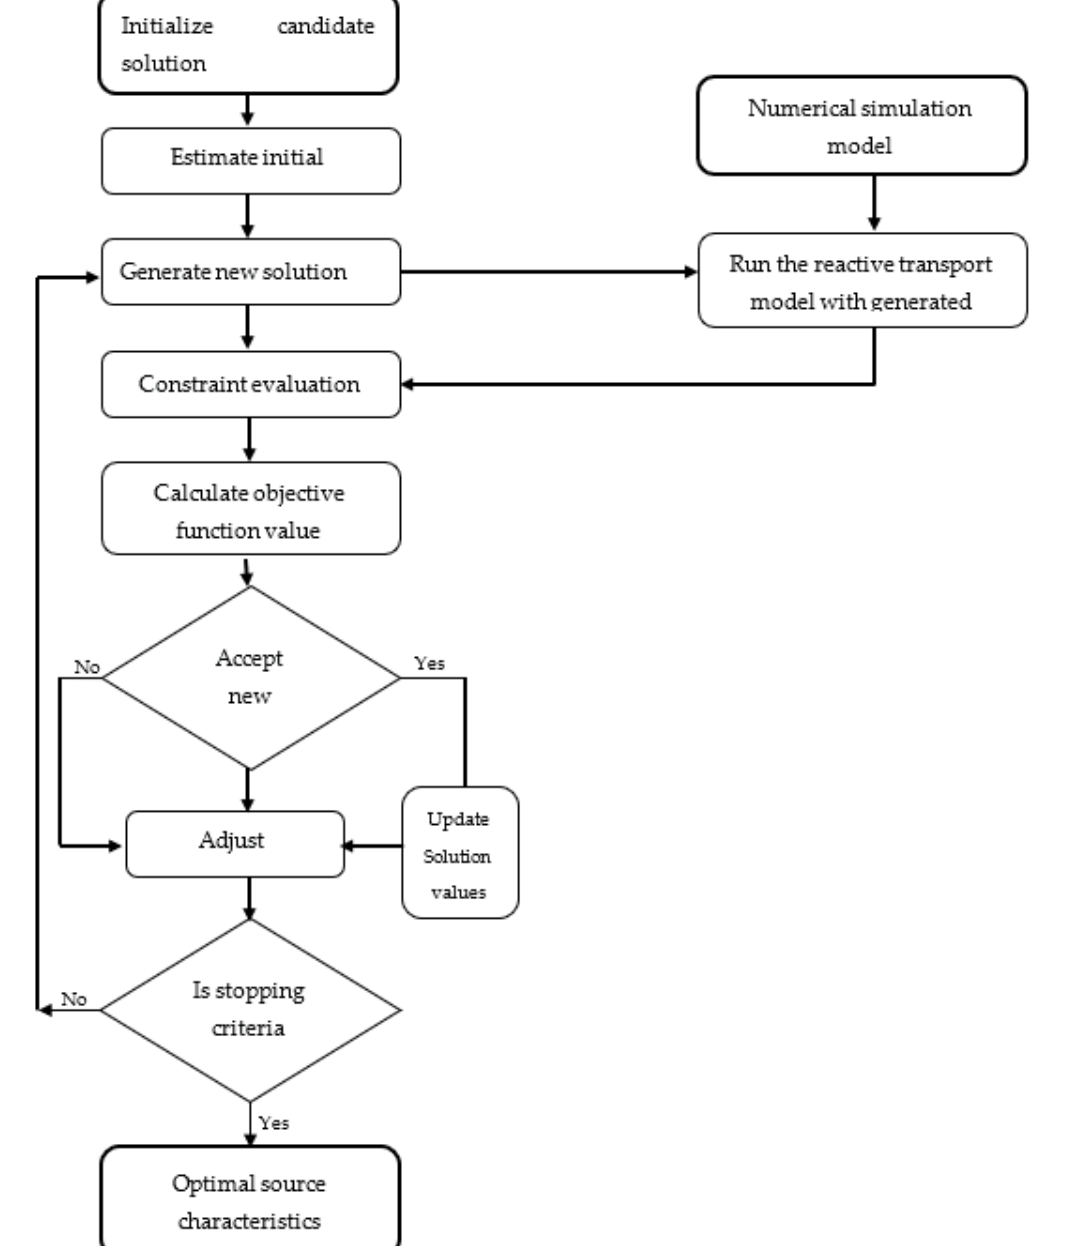
Figure 3. Schematic illustration of the linked simulation-optimization model using adaptive simulated annealing.